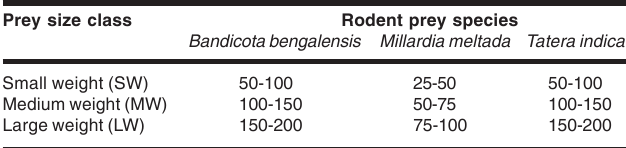
Table 1. Details of rodent prey species, size classes and their weights (g) used in the present study Prey size class